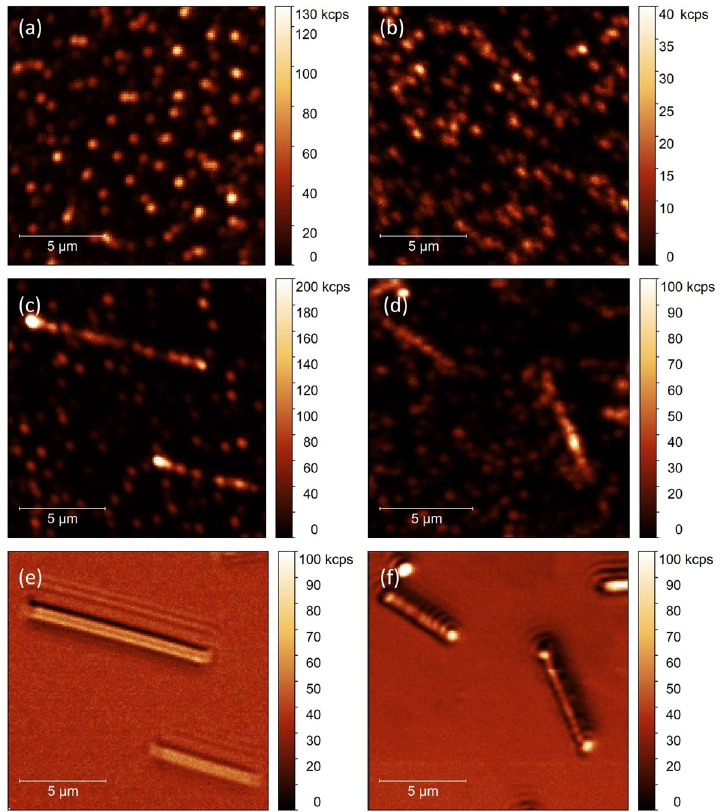
Figure 3. Photoluminescence intensity maps of NaYF 4 :Er 3+ /Yb 3+ nanocrystals deposited on ( a ) glass and ( b ) graphene layer. Maps acquired for NCs coupled with silver nanowires placed on ( c ) glass and ( d ) graphene. Positions of nanowires on ( e ) glass and ( f ) graphene observed in a back scattering mode. Photoluminescence maps were collected at 550 nm under 980 nm laser